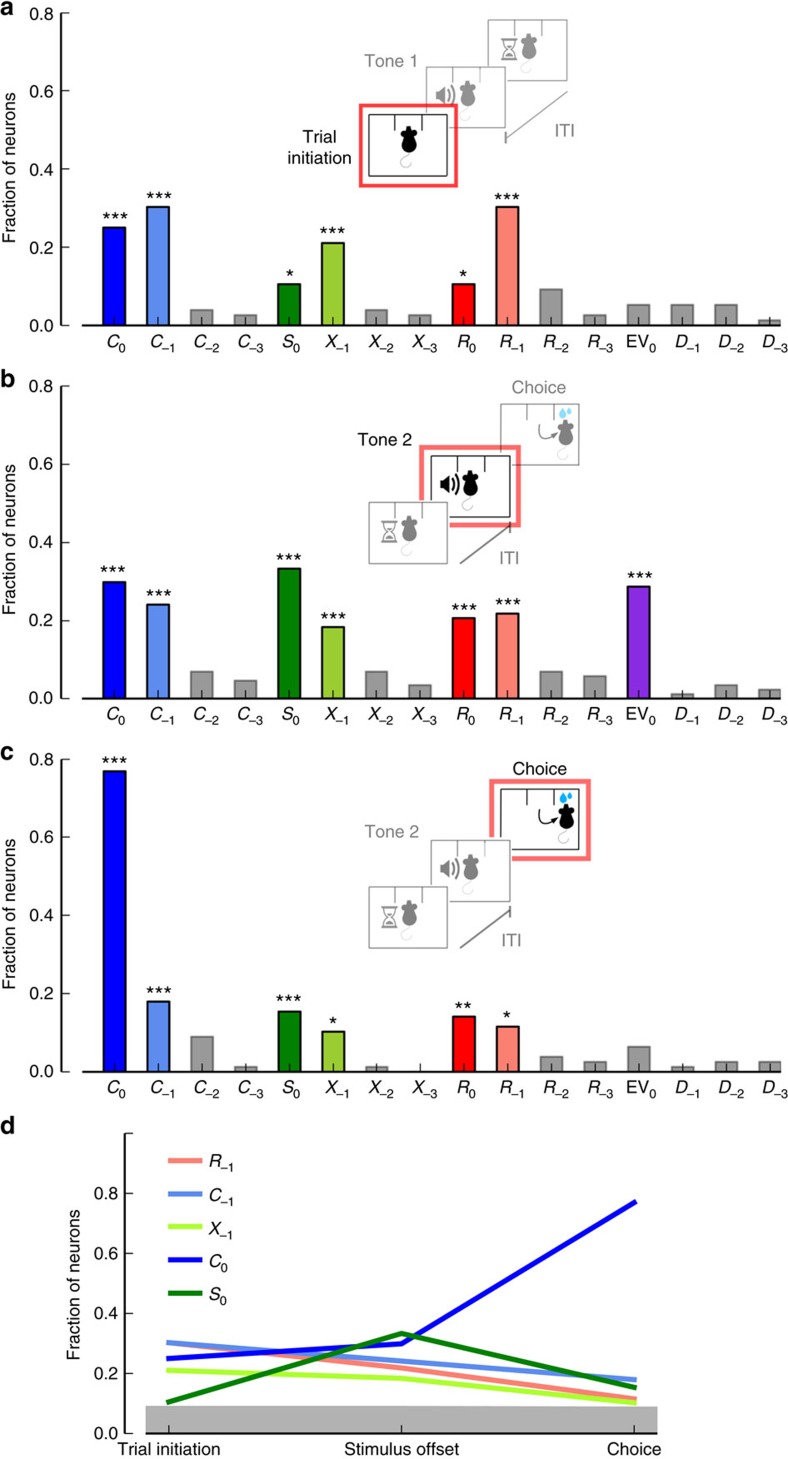
Neurons in lOFC integrate prior with current sensory information and encode upcoming choice.(a) Fraction of neurons with significant regressors (see Methods) for each of the variables listed in the horizontal axis. Upcoming choice C0, previous choice C−1, upcoming stimulus S0, second-order prior X−1, upcoming outcome R0 and previous outcome R−1 are significantly encoded in the population. Upcoming choice C0 is encoded by lOFC neurons even before stimulus is presented. Variables that extend further back into the past are not significantly encoded in lOFC. (b–c) Fractions of neurons with significant regressors during a time period before stimulus offset (b), and during a time period after lateral nose poking (c). (d) Fractions of neurons encoding upcoming choice C0, stimulus S0, second-order prior X−1, previous choice C−1 and previous reward R−1 at trial initiation (pre-stimulus), stimulus offset and choice periods. Note that larger fractions of neurons have choice-related signals as time progresses through the trial. (a–c) One-tailed binomial test, *=P<0.05, **=P<0.01, ***=P<0.001. Shaded rectangle corresponds to non-significant fraction of neurons (P>0.05).